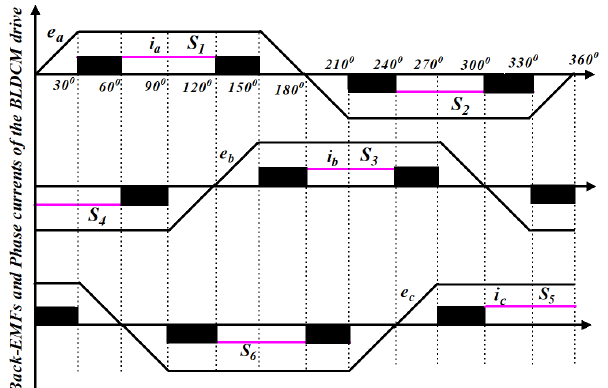
Figure 8. Performance characteristic of the proposed PWM ‐ MAC control techniques.